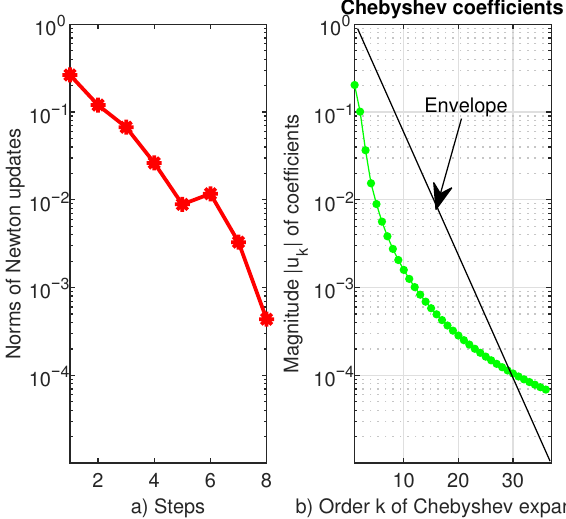
Figure 5. ( a ) The convergence of Newton’s method in solving problem (13) when ν : = 1/2. ( b ) In a log-linear plot we display the decreasing behavior of the Chebyshev coefficients (green dots) of solution to the same